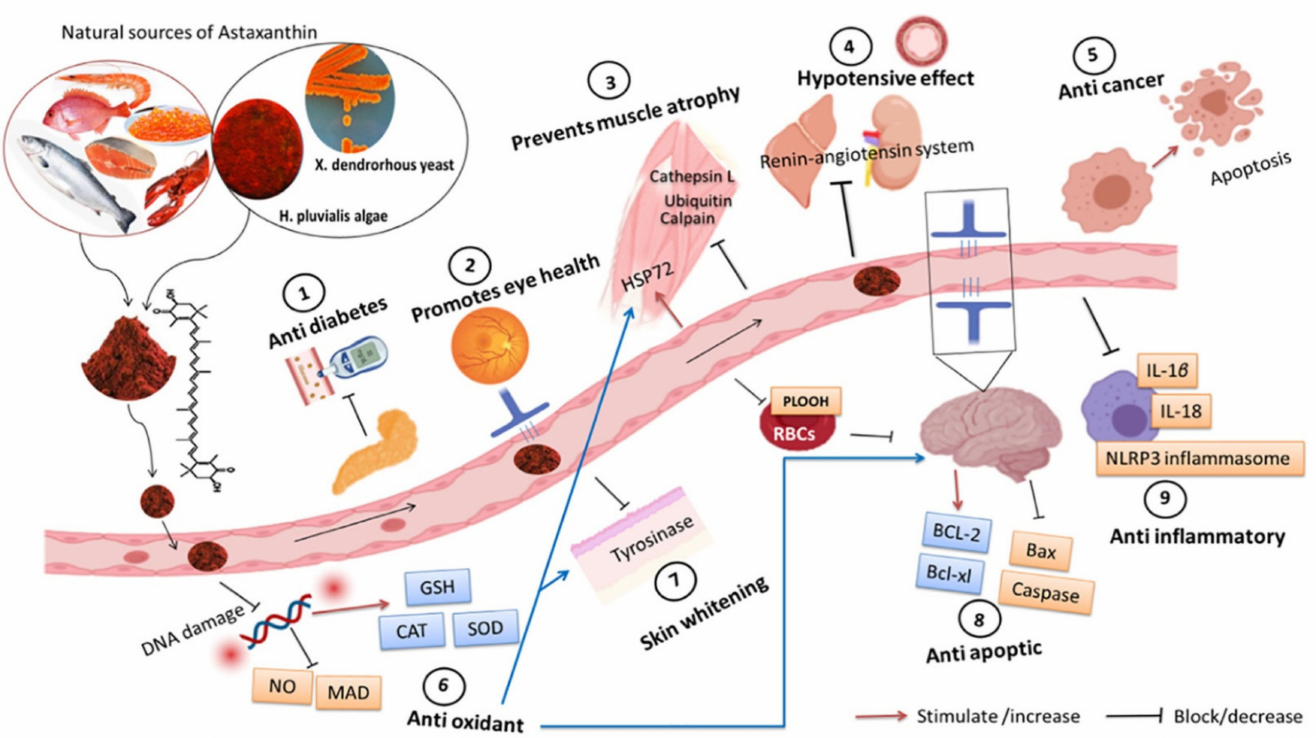
Figure 4. Main effects of astaxanthin. Figure reprinted from [67] with permission from